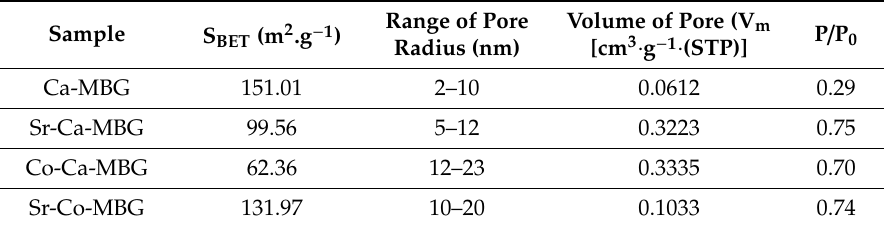
Table 6. Textural characteristics of the synthesized MBGs.